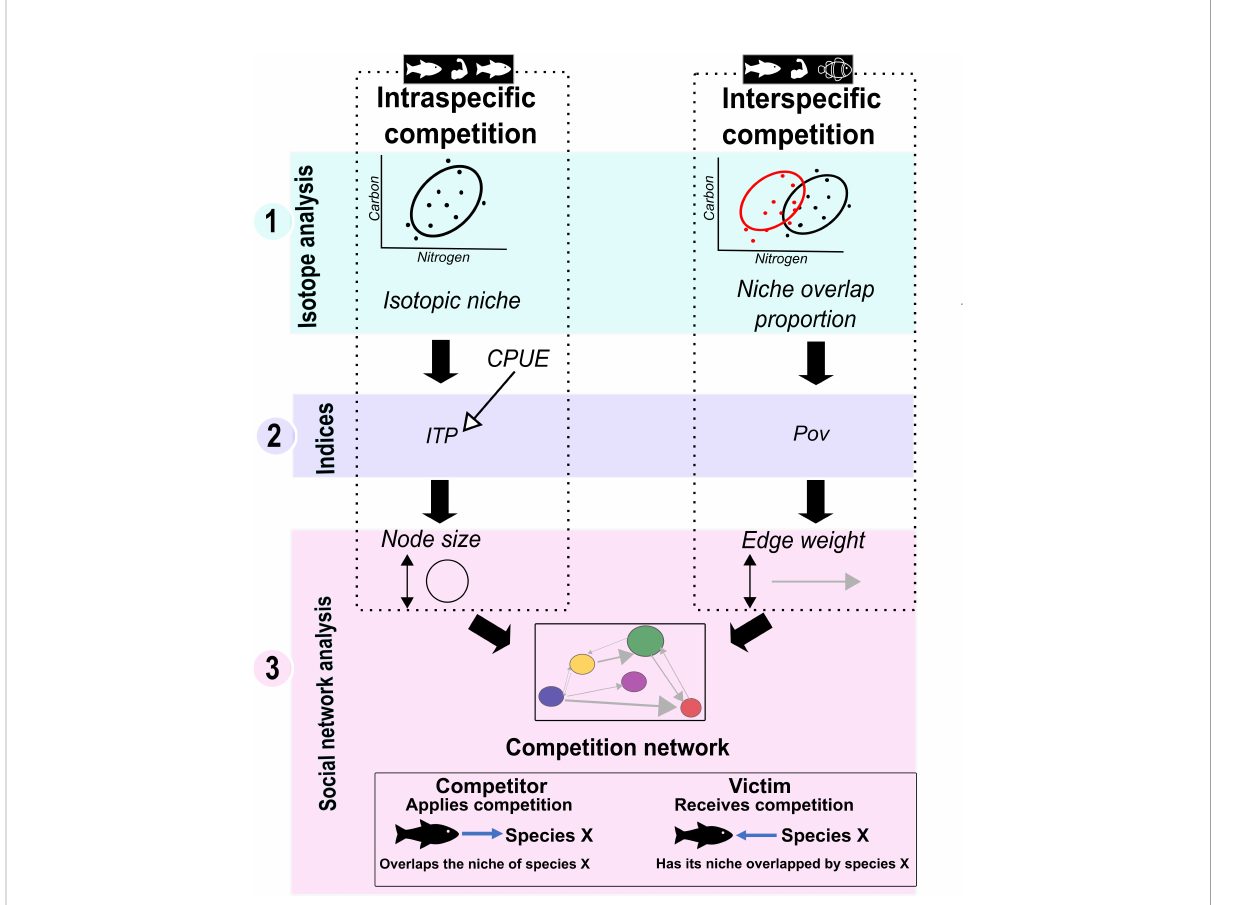
FIGURE 2 Diagram showing the three main methodological steps of data analysis (stable isotope analysis, index calculation, and modeling) to study competition within and among the selected